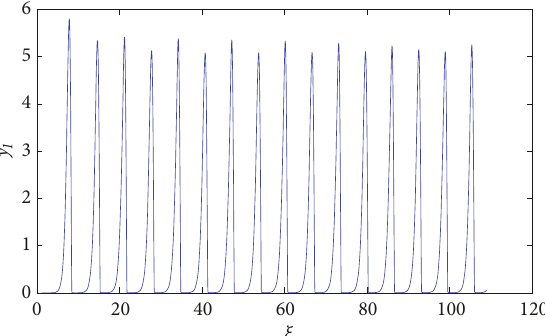
Figure 11: A stick-slip solution of system (27). The parameters 𝑎 = 4, 𝑏 = 15, 𝑉 = 1, 𝑘 = 12 , and 𝜀 = 0.1 . 𝑝𝑙 0